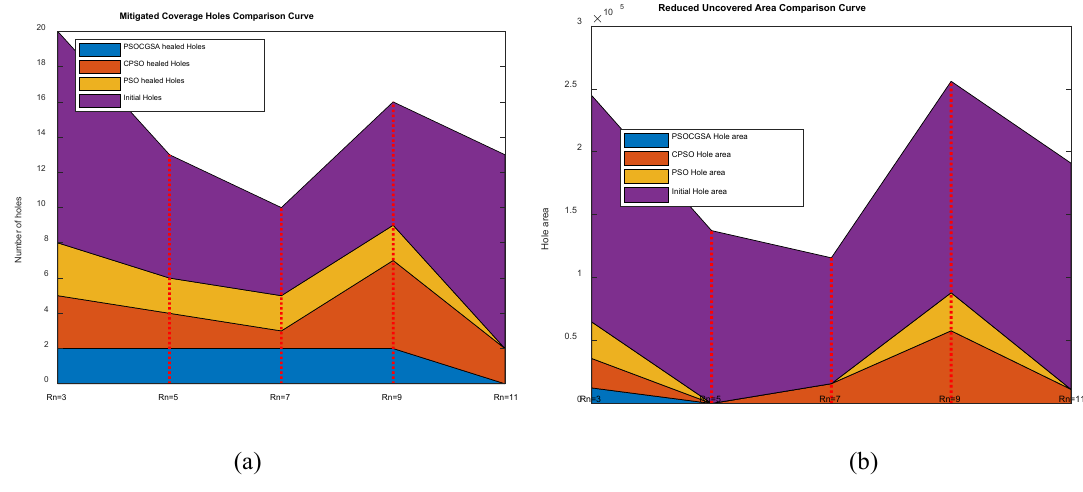
Figure 7. Comparison of (a) number of detected holes (b) reduced uncovered area by PSOCGSA, CPSO,